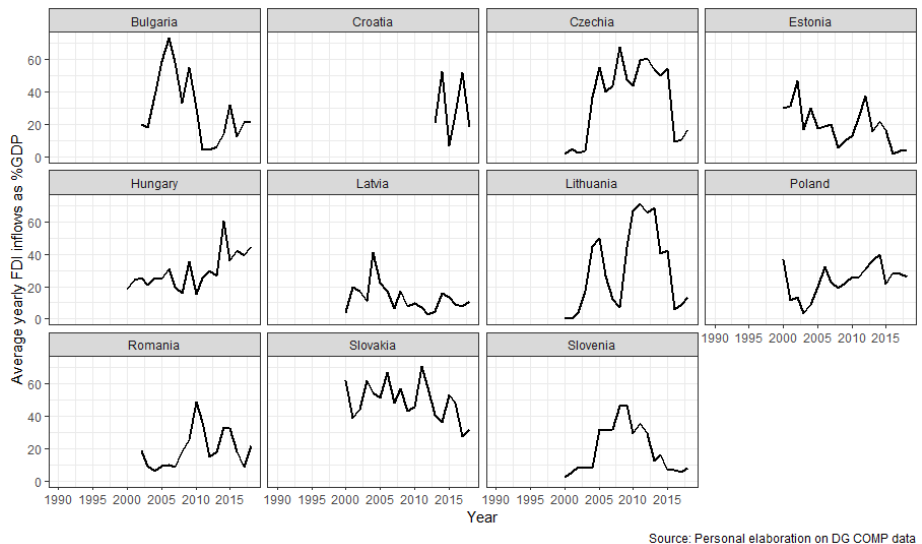
Figure A3 : Horizontal aid as % total aid in the CEECs by country (1990-2018)